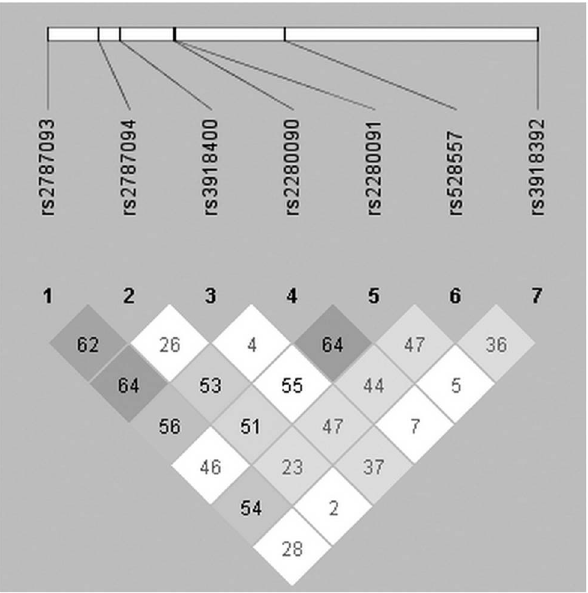
Figure 1. Linkage disequilibrium of seven SNPs in the ADAM33 gene. Linkage disequilibrium (LD) of 7 SNPs was determined using the solid spine of LD option of Haploview 4.1. D 9 values are displayed in the squares. Empty red squares have a pairwise D 9 of 1.00. Red squares indicate high pairwise LD, gradually coloring down to white squares of low pairwise LD.